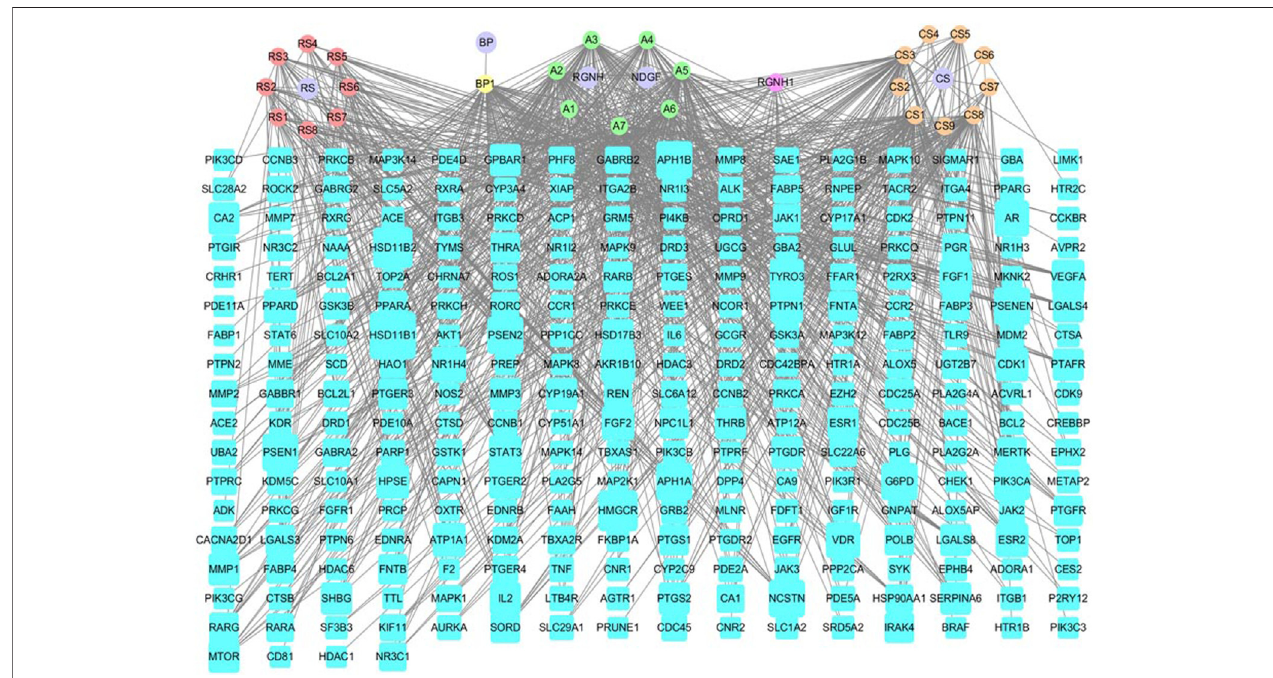
FIGURE 6 | Drug-ingredient-target network of HJP (RS: Panax ginseng C. A. Meyer. CS: Venenum Bufonis. BP: Borneolum. RGNH: Arti fi cial Calculus Bovis. NDGF: Ox Bile Powder. The purple round nodes were composed of drugs surrounded by their particular ingredients. The blue rectangular node represented the gene targets.).